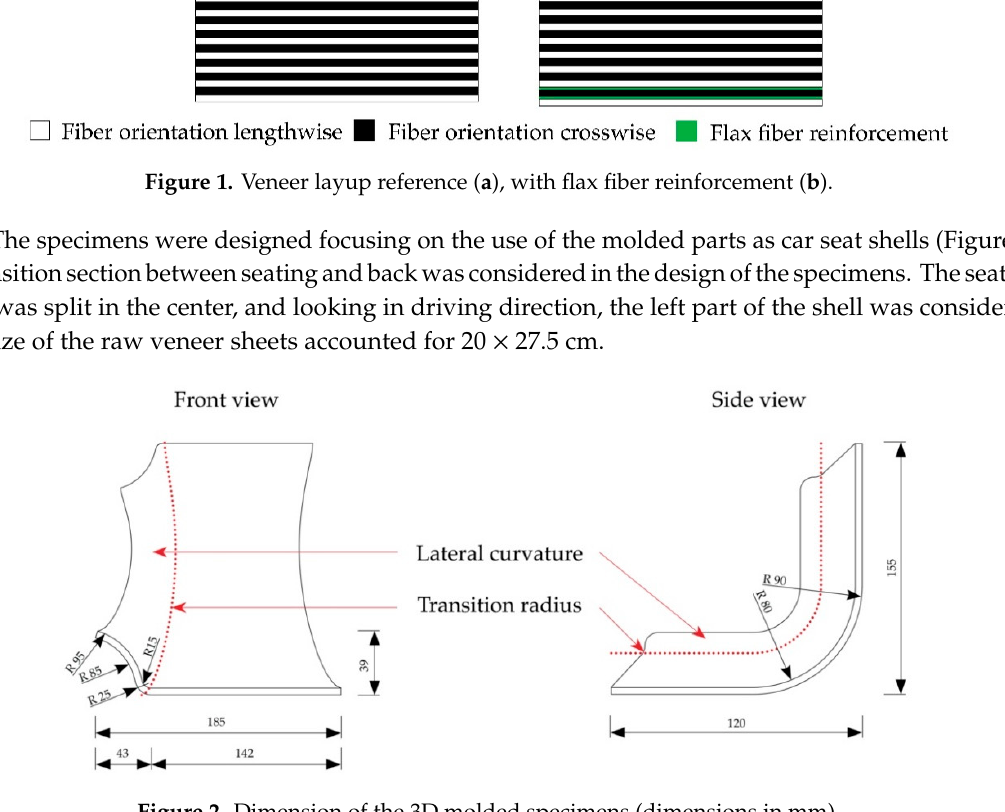
Figure 2. Dimension of the 3D molded specimens (dimensions in mm).